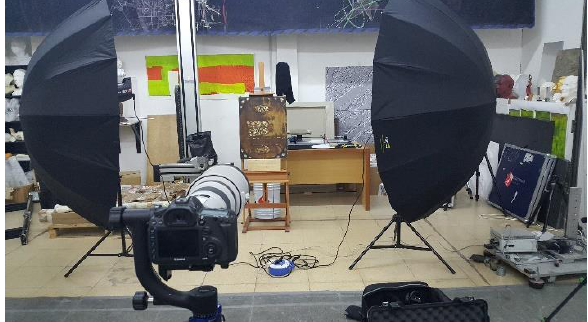
Figure 5. Colour photography capture setup for the unnamed